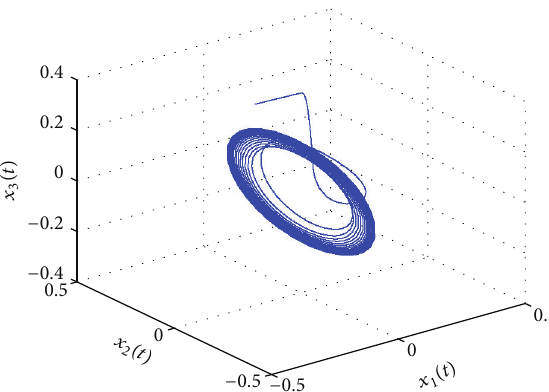
Figure 4: The phase plot of 𝑥 1 , 𝑥 2 , and 𝑥 3 when 𝜏 1 = 1.5 > 1.4022 = 𝜏 10